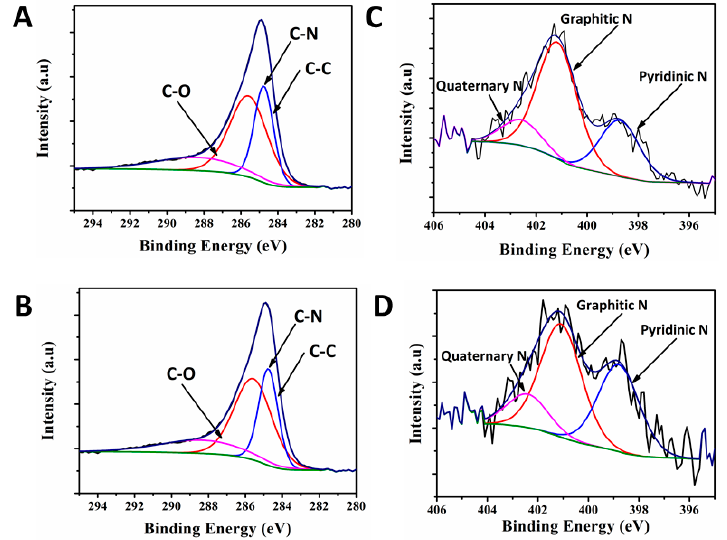
Figure 3. ( A , B ) are the XPS spectra of the deconvoluted C1s region; and ( C , D ) are the deconvoluted N1s region of GAL-N and GAL-Fe-N, respectively.